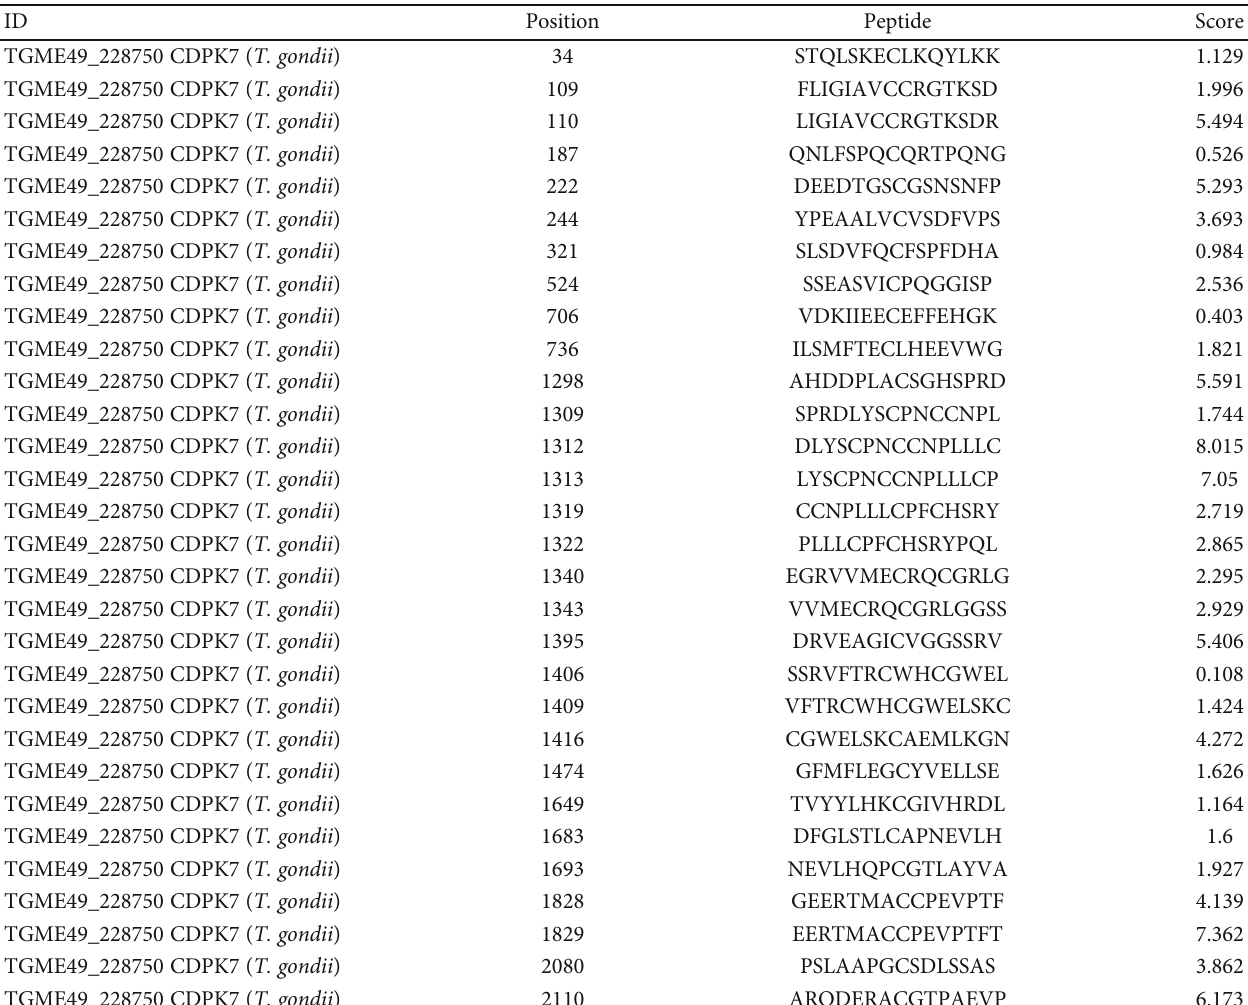
Figure 1: NetPhos server output for CDPK7 phosphorylation sites. (a) The number of predicted sites, based on S (serine), T (threonine), and Y (tyrosine); (b) prediction diagram of CDPK7 phosphorylation sites. Table 1: The acylation sites of CDPK7